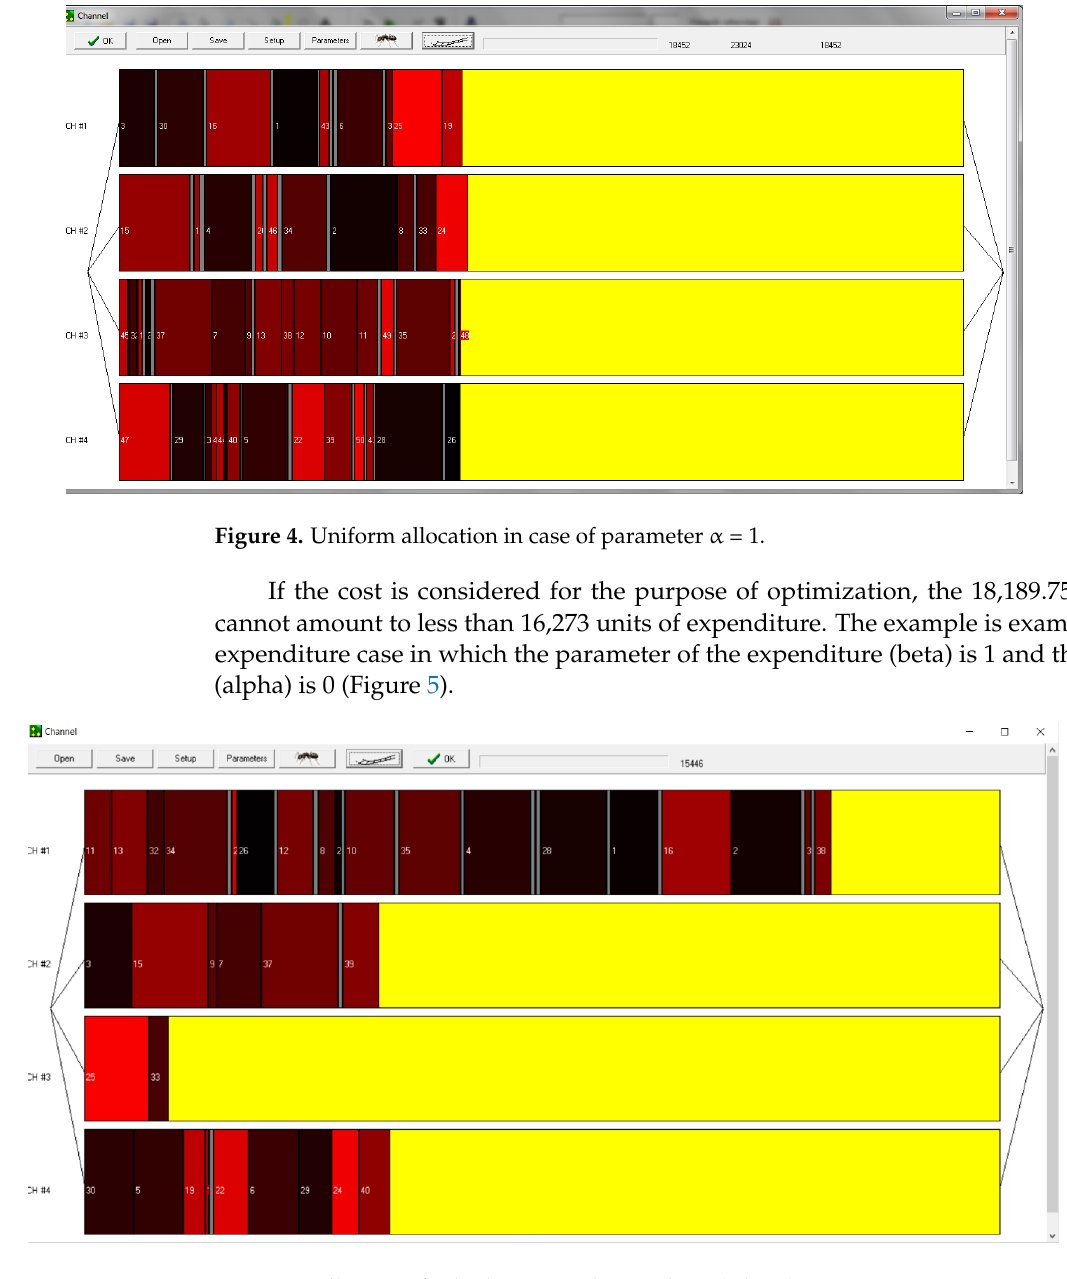
Figure 5. Allocation for high-cost production lines (3 lines).